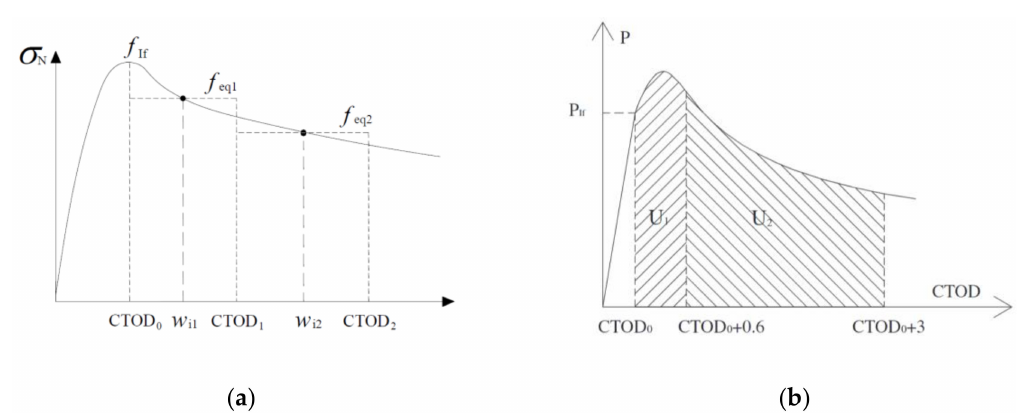
Figure 6. ( a ) Tensile strength based on the bending test results; ( b ) load-CTOD curve example. Figures extracted from CNR DT 204/2006 [55] and from UNI 11039-2 (2003)